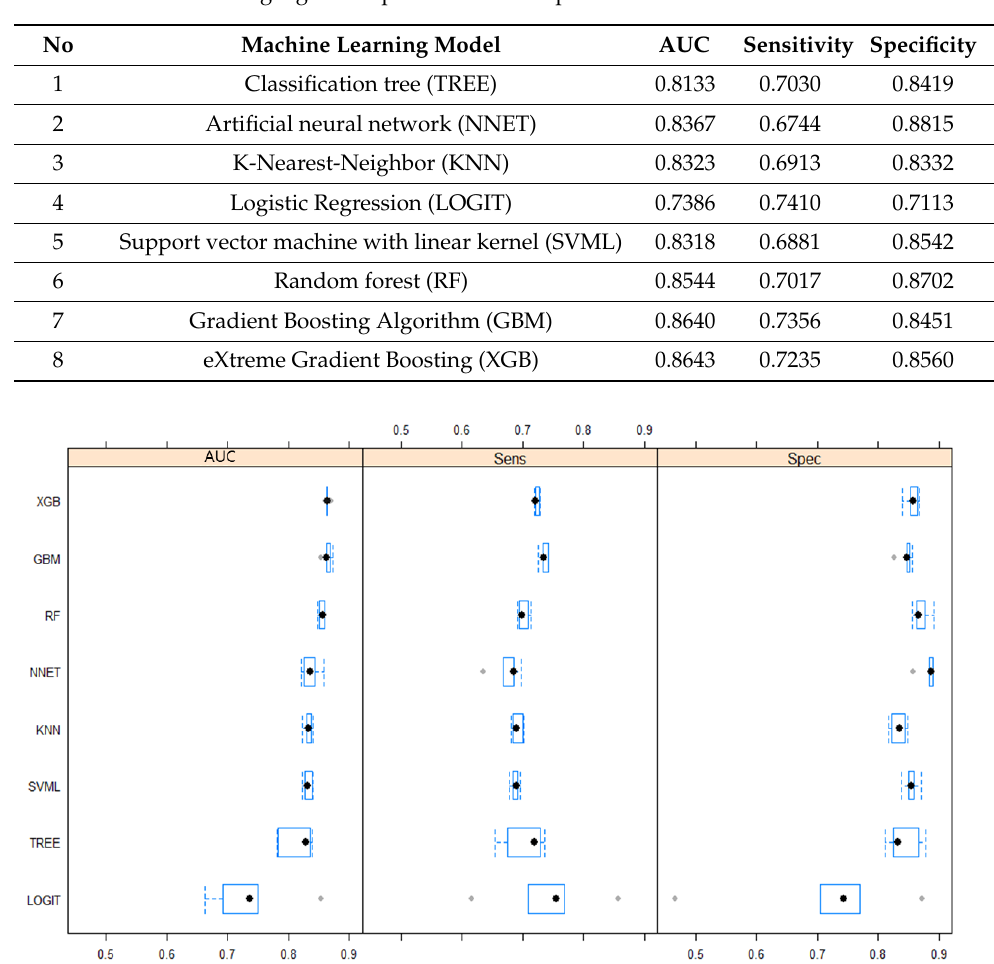
Figure 2. Comparison of machine learning model performance.